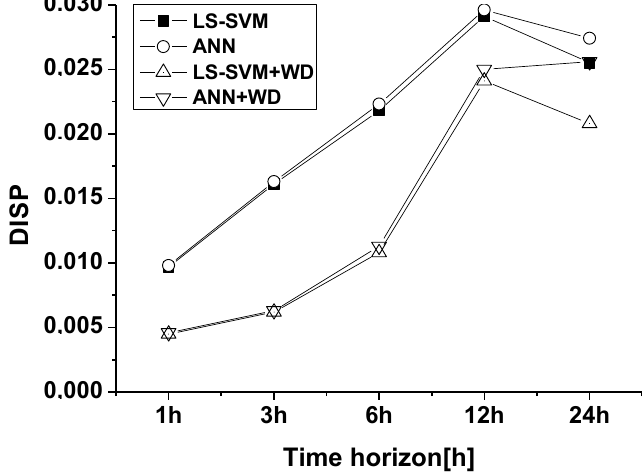
Figure 9. DISP for input vector Type II by LS-SVM and ANN without and with